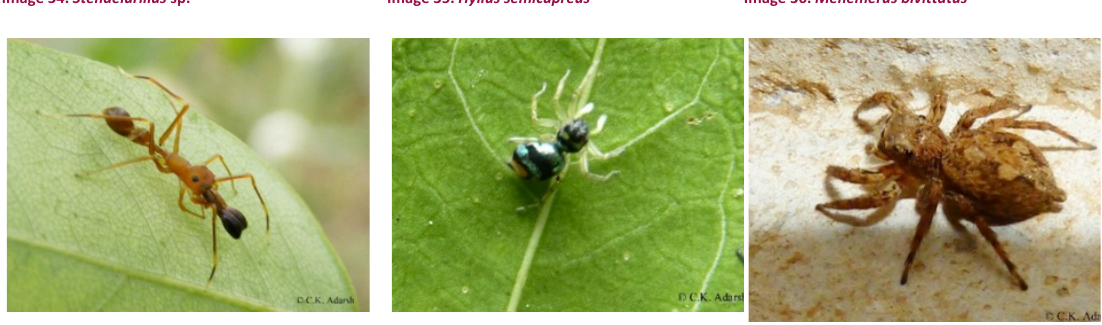
image 34. Stenaelurillus sp. Image 35. Hyllus semicupreus Image 36. Menemerus bivittatus